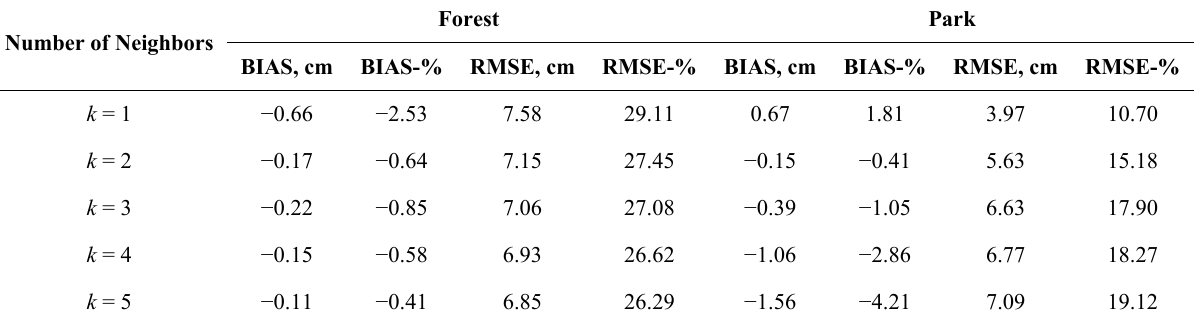
Table 5. Accuracy in DBH